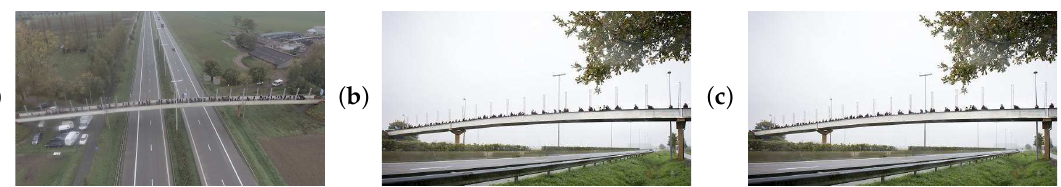
Figure 1. Impressions of the Eeklo footbridge during the large-scale measurement campaign: ( a ) top, ( b ) side and ( c ) below view.